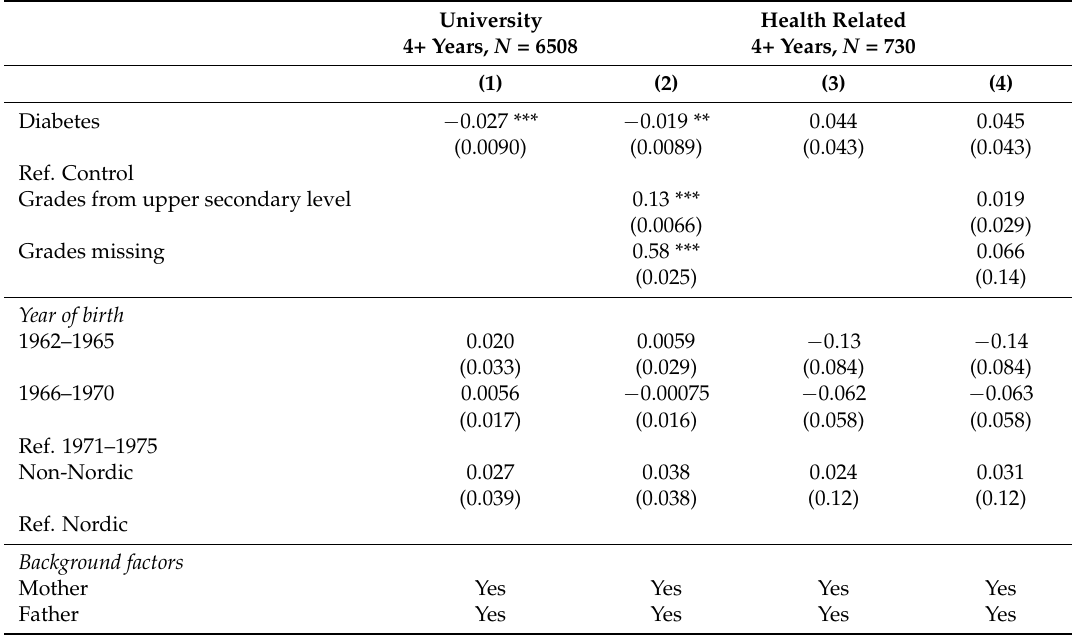
Table 8. Average marginal effects of women’s probability of having a university education longer than four years and the probability of having a health-related university education longer than four years for those with a university education longer than four years.